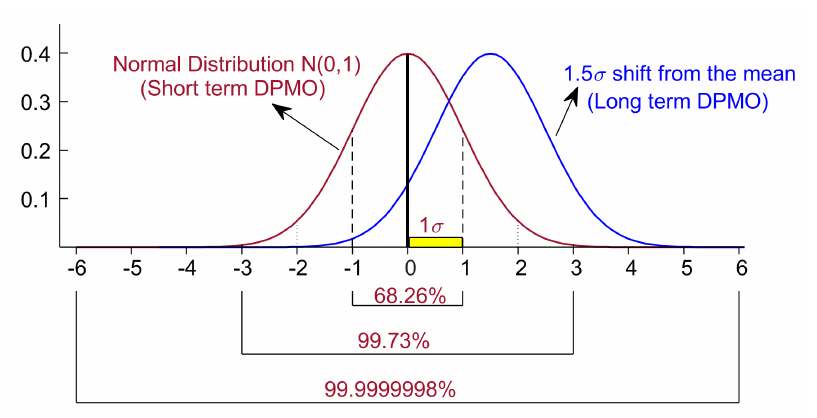
Figure 5. Probability density function of the standard normal distribution for short-term quality control and long-term quality control (with a 1.5 σ shift from the mean), with probabilities for three sigma